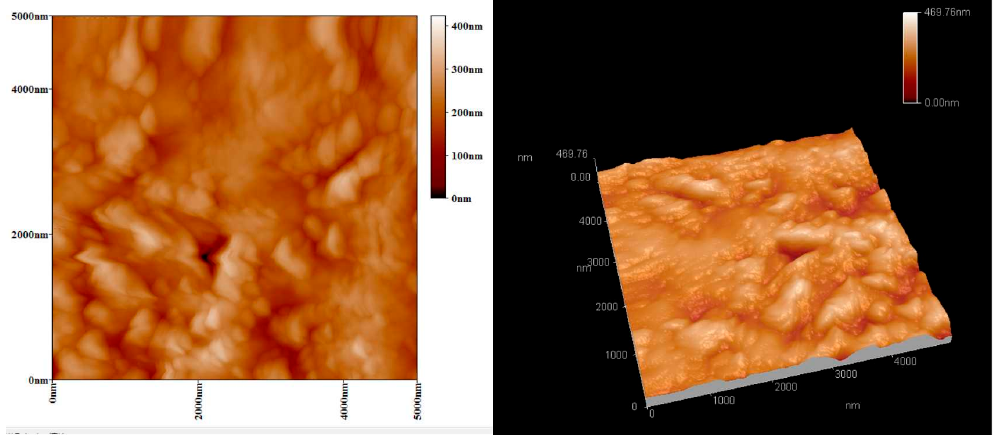
Figure 6. AFM images of the FP/PAN composite film after the electroless plating of copper.